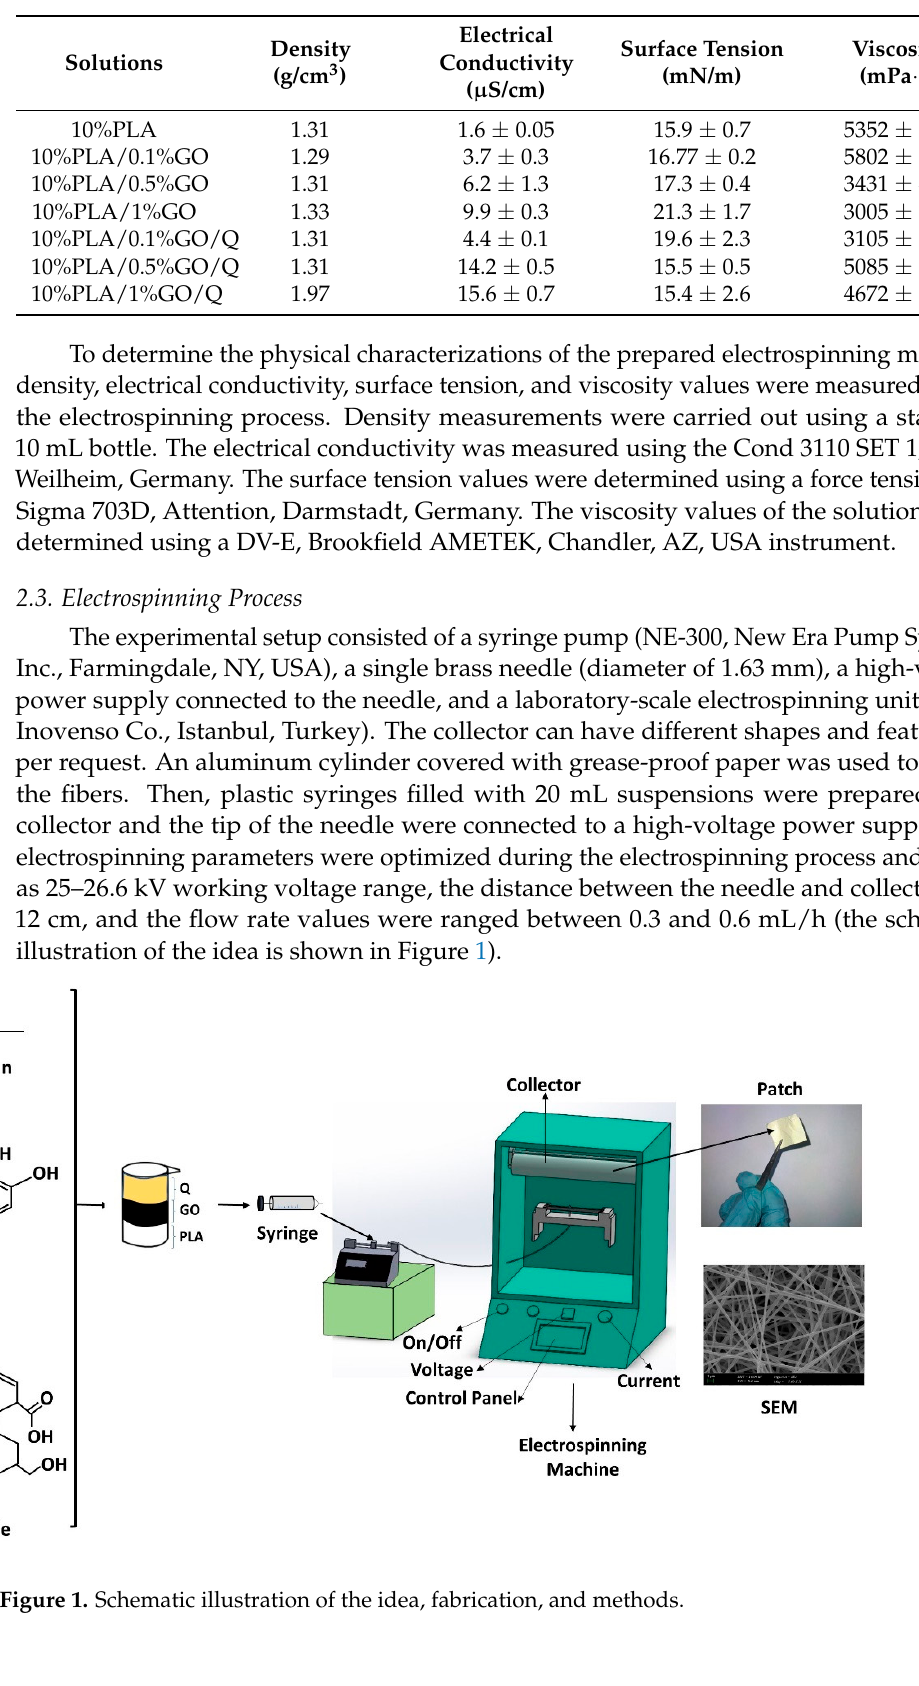
Table 1. Physical properties of the microfiber suspensions.